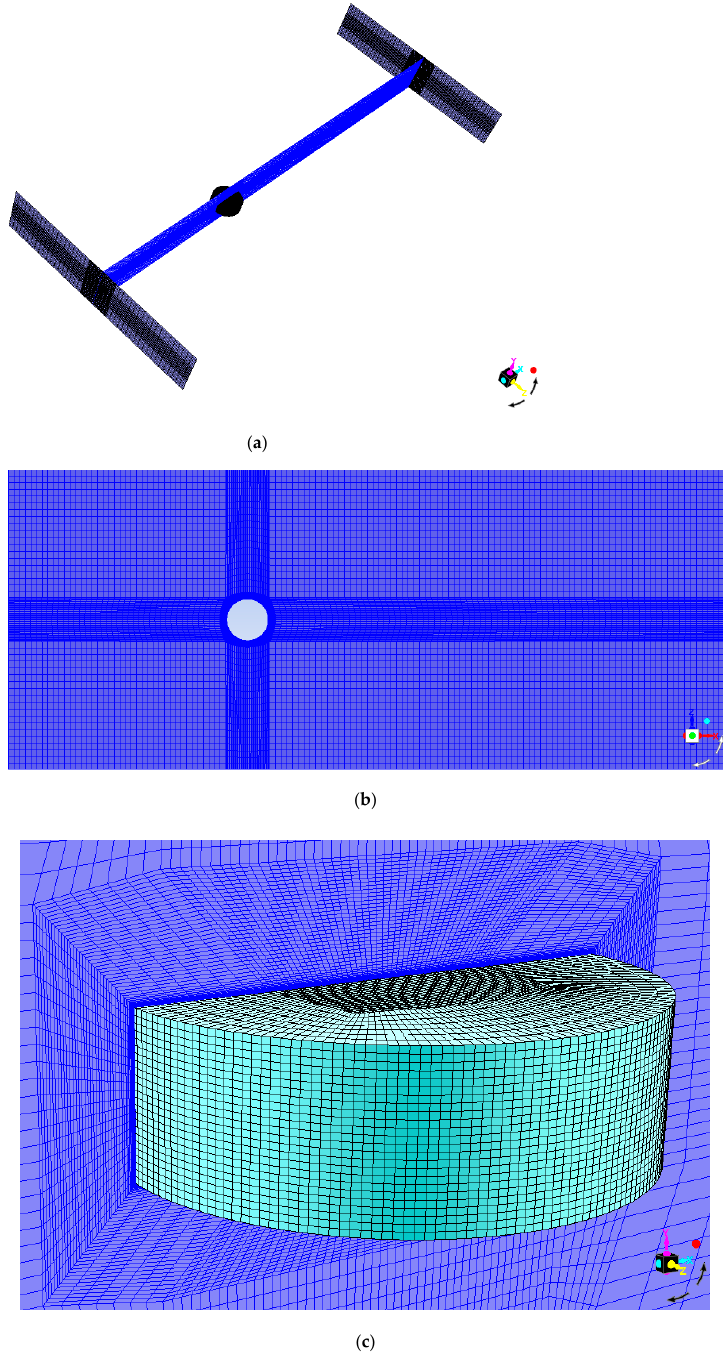
Figure 3. ( a ) The computational mesh; ( b ) Top view; ( c ) Detail of mesh near cylinder.